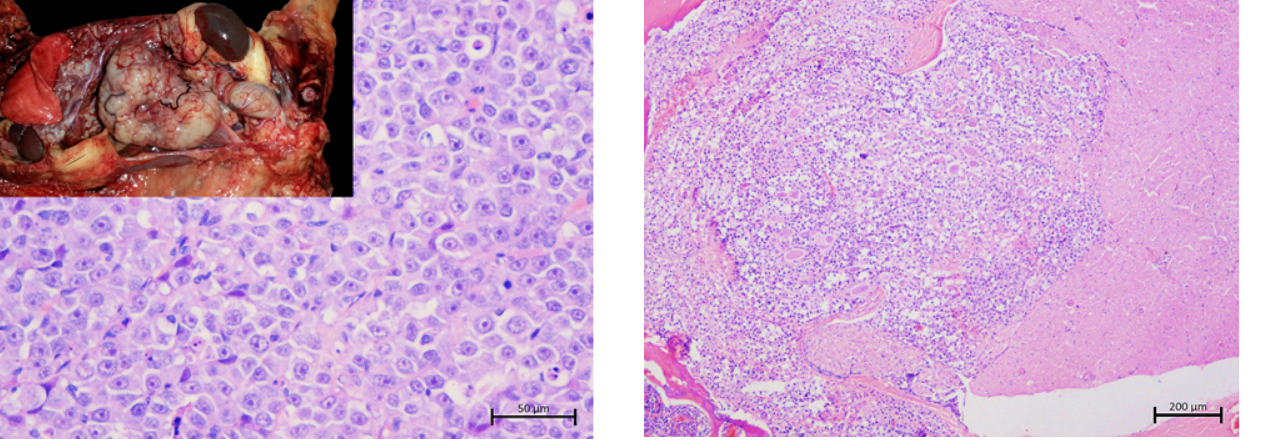
Figure 1: Neoplastic cells in the testicular mass of a Southern African hedgehog. Large, polyhedral neoplastic cells, with relatively distinct cell borders, vesicular nuclei with prominent nucleolus and scant to moderate finely granular to vacuolated eosinophilic cytoplasm. Neoplastic cells show a moderate to high degree of anisocytosis and anisokaryosis (HE stain, bar = 50 µ m). Inset: In situ presentation of the large neoplastic mass affecting the left testicle with metastasis to the peri-renal tissue, vertebral column and diaphragm (liver and intestinal tract removed).